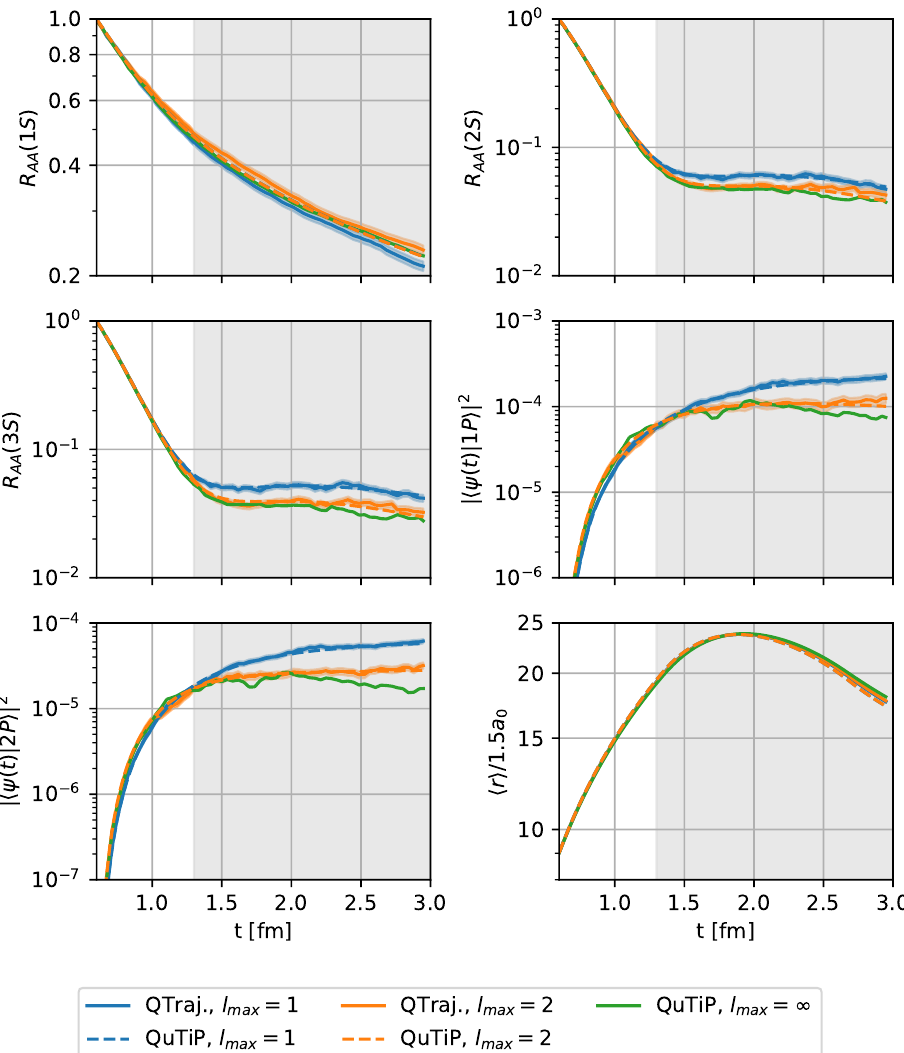
Figure 3 . A comparison of the overlap of an initial Gaussian state of width c = 0 . 2 with the lowest lying Coulomb states and the expectation value of the radius computed using QuTiP and the QTraj algorithm. Curves and simulation conditions are as in figure 2. The gray band denotes the area where the wave-function hits the edge of the lattice, i.e., finite size effects become relevant, which occurs at t = 1 . 3 fm (see text for discussion). We note that for the S -wave states we report their overlaps normalized to their initial overlaps and denote this quantity R AA